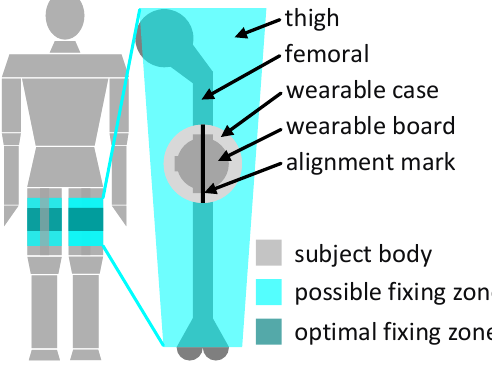
Figure 9. Diagram of the mounting position on a patient with detailed mounting position on patient’s